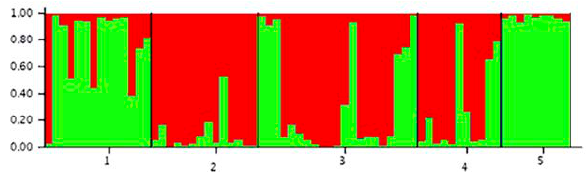
Figure 5. STRUCTURE plot of Ziziphora clinopodioides provinces based on k = 2. (Provinces 1-5 are: 1- Qazvin, 2- Razavi Khorasan, 3- Mazandaran, 4- Tehran, and 5- Ardebil).